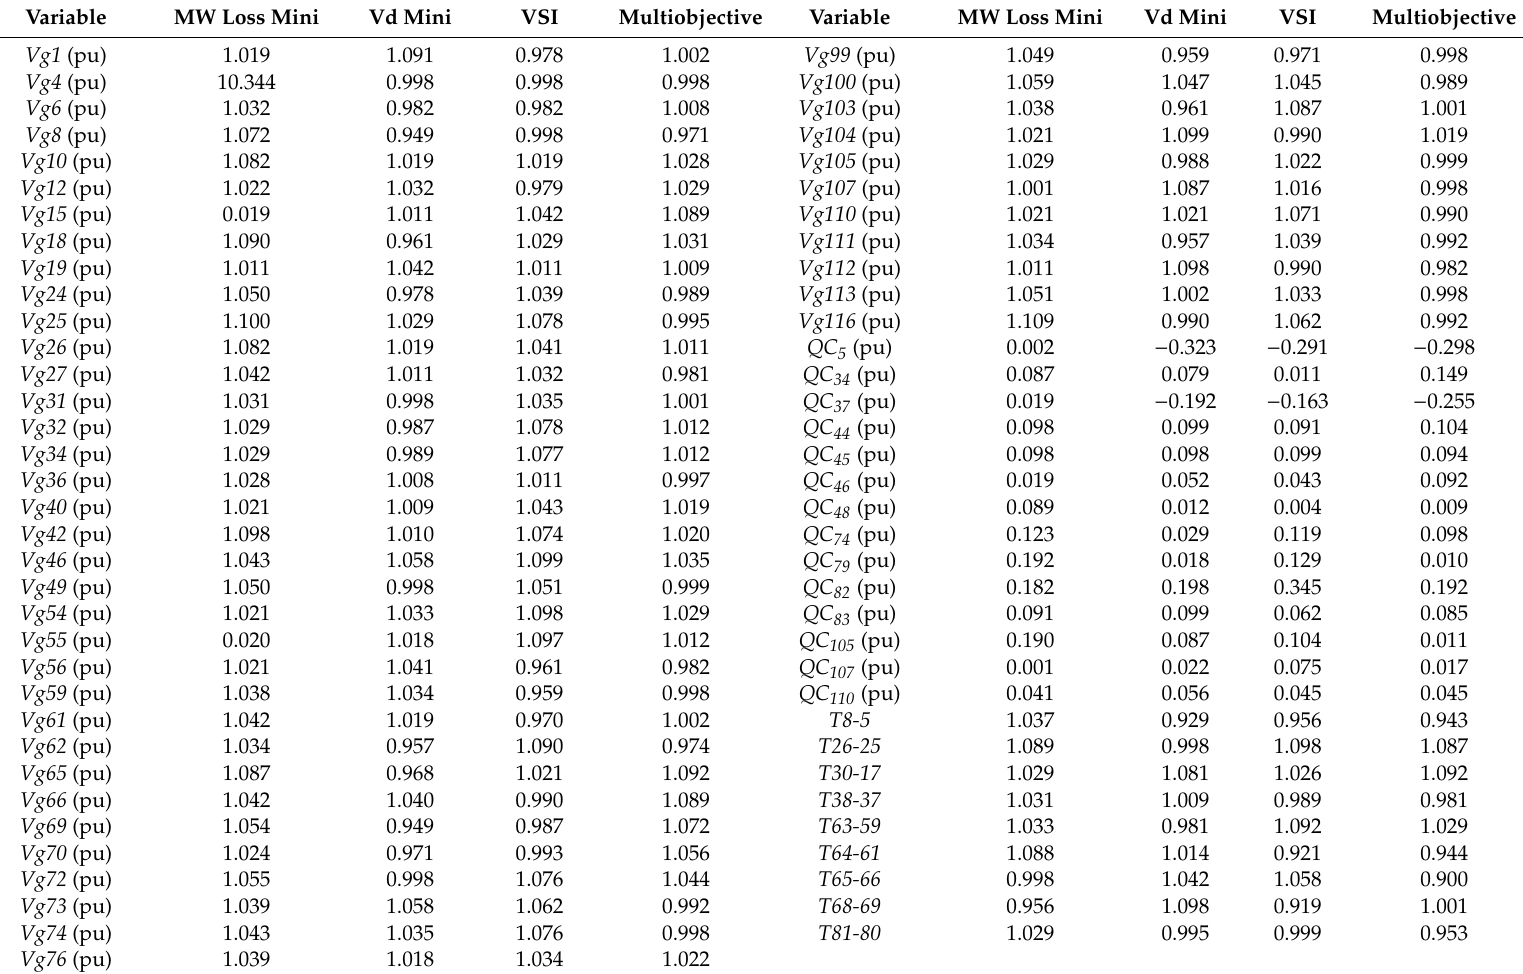
Table 6. Results of the single and multiobjective fitness functions of the APOPSO algorithm on the IEEE 118 test